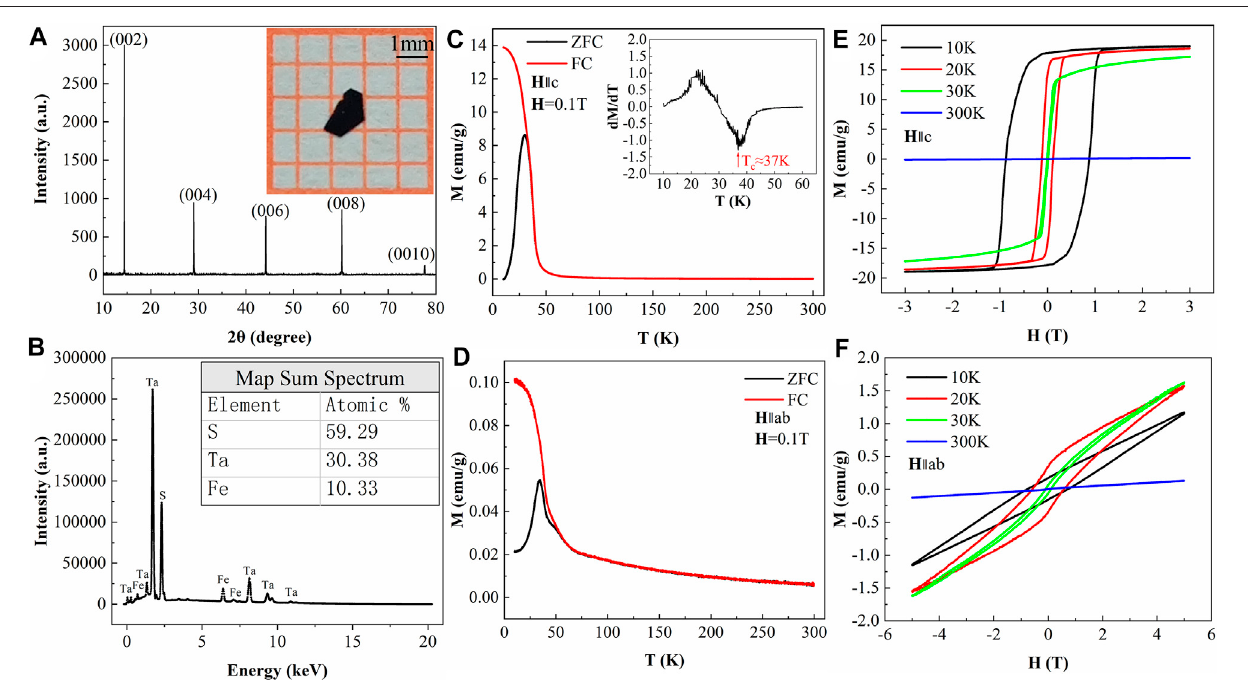
FIGURE 1 | (A) XRD pattern of a FeTa 3 S 6 single crystal, and the inset is an optical image of the FeTa 3 S 6 single crystal; the scale is 1 mm. (B) EDS pattern of the FeTa 3 S 6 single crystal, and the inset shows the actual atomic ratio. (C) Temperature-dependent magnetization measured of zero- fi eld cooling (black) and fi eld cooling (red) with H (cid:3) c, and the inset shows the dM/dT curve of zero- fi eld cooling with H (cid:3) c. (D) Temperature dependence of the magnetization measured of zero- fi eld cooling (black) and fi eld cooling (red) with H (cid:3) ab. (E) Field-dependent magnetization (M-H) at different temperatures with H (cid:3) c. (F) Field-dependent magnetization (M-H) at different temperatures with H (cid:3)